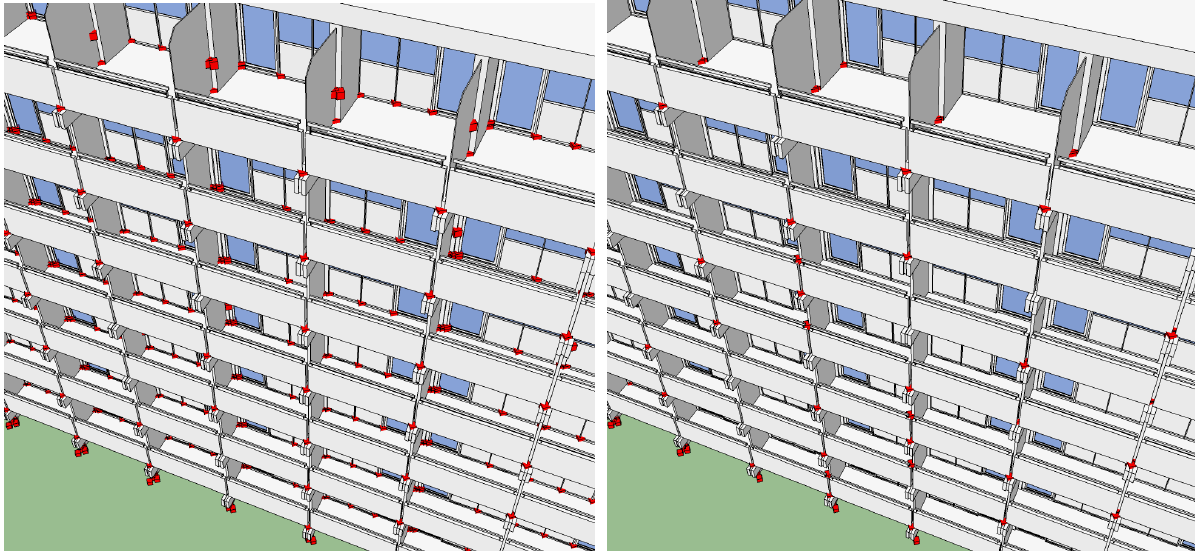
(a) Simulated phase centers for signal incidence angle of 39.09 ◦ . Corner reflections appear in the balcony interior (dominant) and on the balcony railing (negligible). Figure 5: Simulated phase centers related to reflection level 3 marked in facade model (red cubes). The change of the signal incidence angle leads to a loss of corner reflections at the balcony